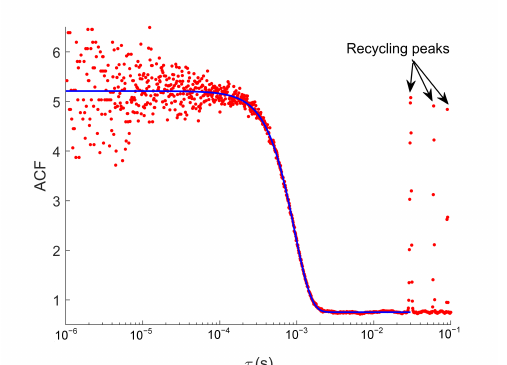
Figure 5. ACF of immobilized fluospheres in SMR. The laser beam is adjusted to fit the inner diameter of the capillary microchannel. The peaks on the right of the slope represent the intervals between passages in SMR, which are 30 ms, 60 ms, and 90 ms, respectively. The curve of ACF is fitted by Equation